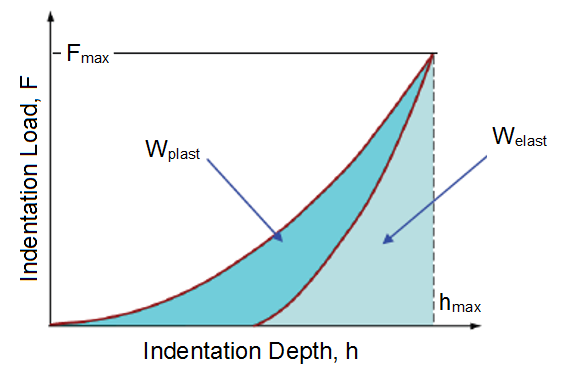
Figure 3. Indentation work η IT